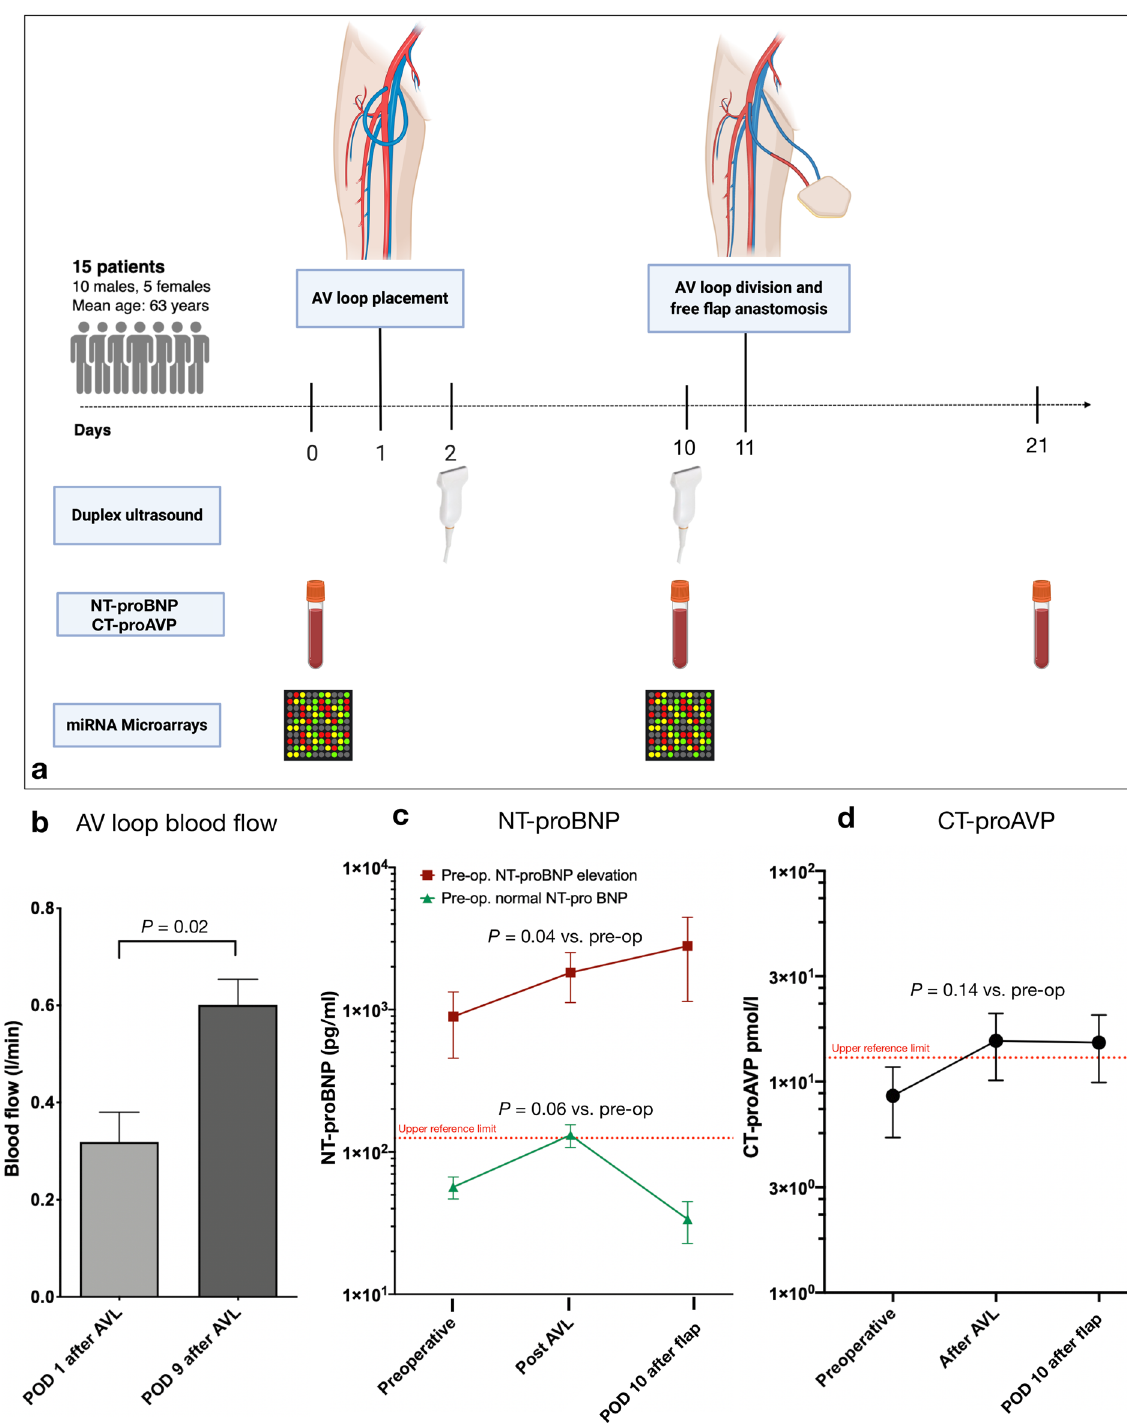
Figure 2. ( a ) Workflow of the study. AV loop = arteriovenous loop, NT-proBNP = N-terminal pro-brain natriuretic peptide. CT-proAVP (Copeptin) = (C-terminal part of pro-Arginine Vasopressin) ( b ) Comparison of mean blood flow in the AV loop as determined by duplex ultrasound on postoperative day (POD) 1 and 9 after AV loop placement. ( c ) Serum NT-proBNP concentration (y axis, logarithmic) in patients with pre-operatively (pre-op.) normal (green) or elevated (red) NT-proBNP levels. ( d ) Copeptin (C-terminal part of pro-Arginine Vasopressin) concentration; Preoperative = before AV loop placement; Post AVL = POD 9 after AV loop placement; POD 10 after flap = postoperative day 10 after flap anastomosis to the AV loop; * = p < 0.05. Figure schematic created with